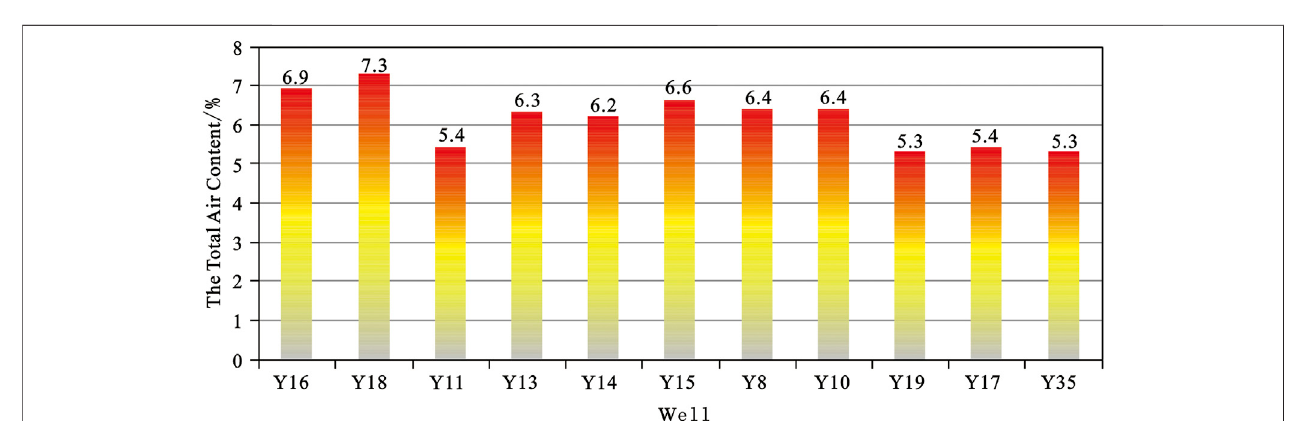
FIGURE 9 | Total gas content distribution histogram of the Leping Formation carbonaceous shale in the study area.